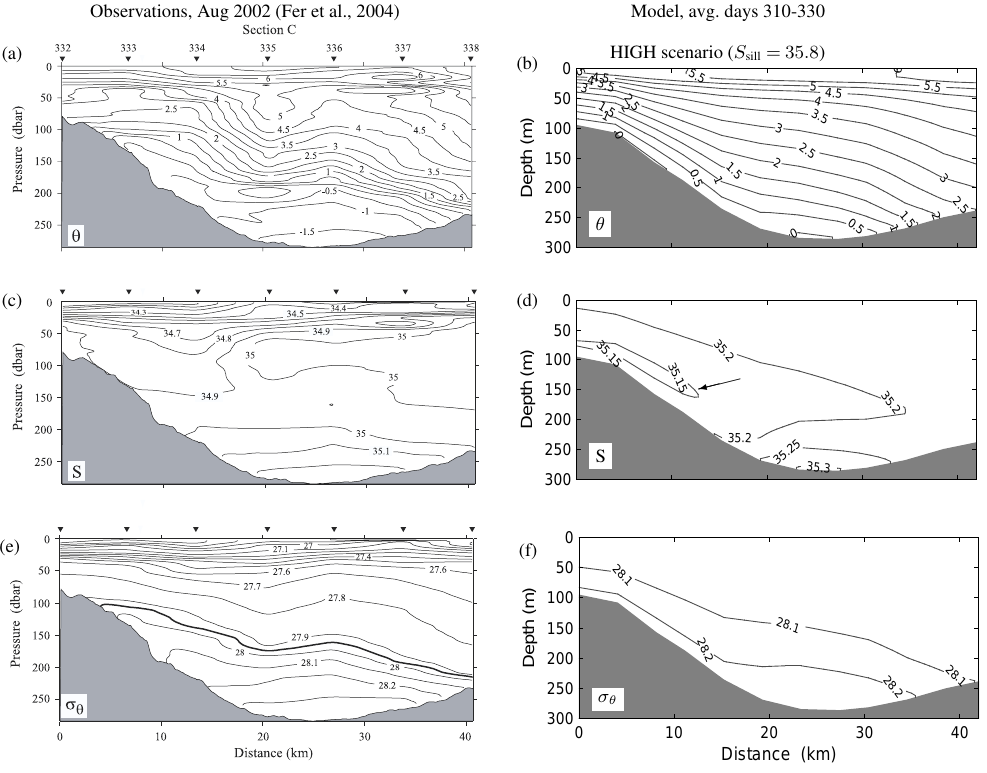
Fig. 3. Comparison of cross section C in Fer et al. (2004) (left) with model of the HIGH overflow scenario ( S sill = 35 : 8 , with tides and wind) (right). Observations and averaged model cross sections show the plume approximately 4 months after the peak overflow period. The arrow points out a patch of low salinity.